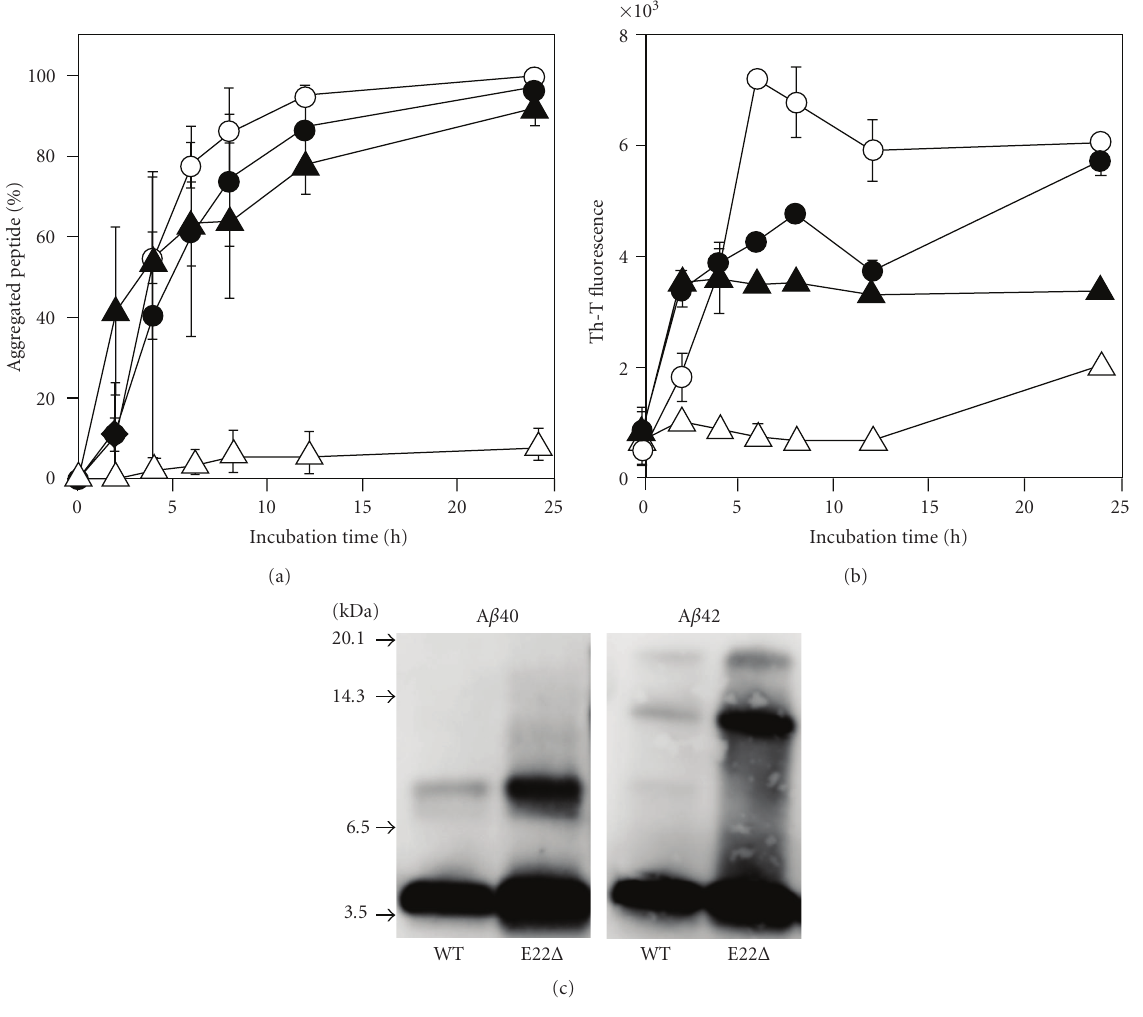
Figure 1: Aggregation profiles of E22 Δ -A β 40 and E22 Δ -A β 42 (25 μ M) after incubation at 37 ◦ C. (a) Sedimentation assay estimated by HPLC analysis after centrifugation. (b) Th-T fluorescence assay. ◦ , A β 42; (cid:3) , A β 40; • , E22 Δ -A β 42; (cid:2) , E22 Δ -A β 40. (c) Western blotting without